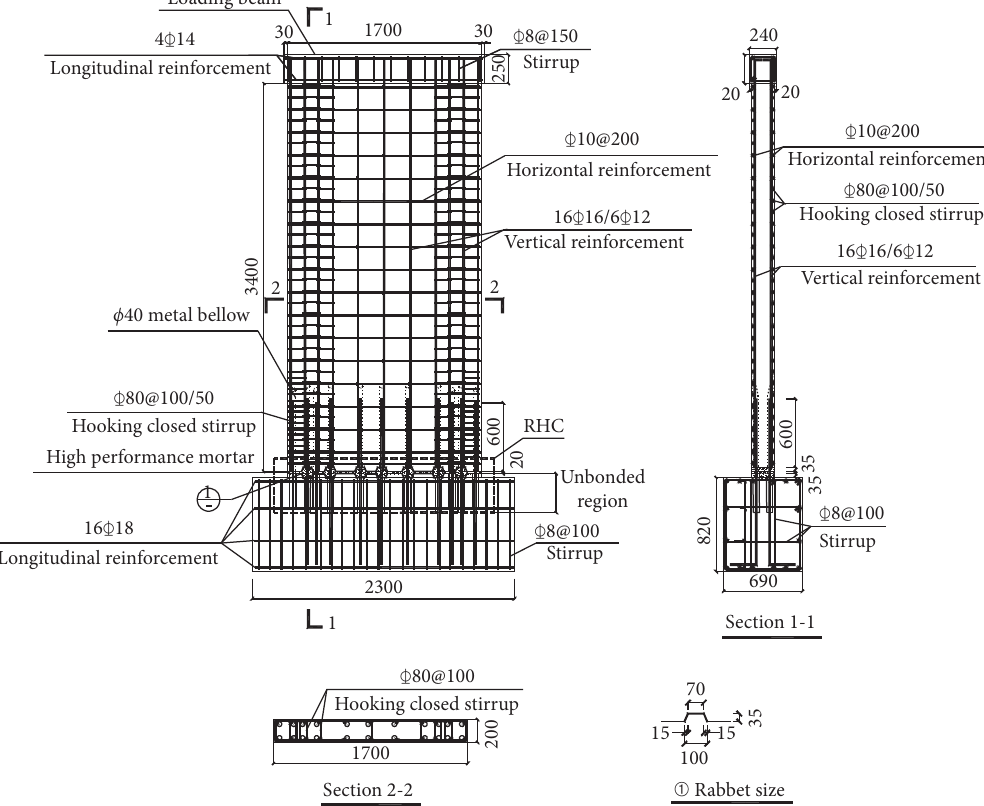
Figure 7: Dimension and rebar details of test specimen in